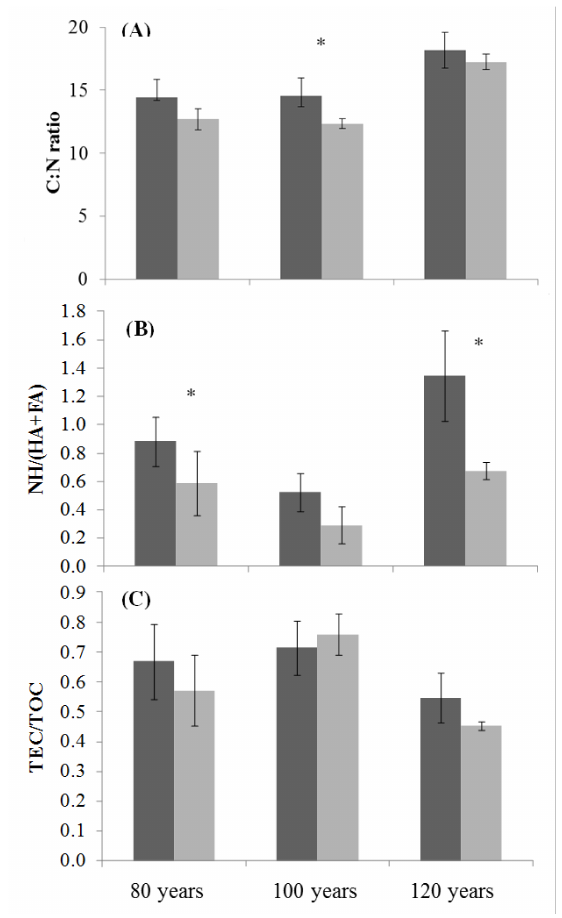
Figure 5. Soil organic matter properties in the epipedon (dark grey) and endopedon (light grey) along the Douglas fir stand chronosequence: C:N ratio ( A ), humification index: non-humic (NH) to humic carbon ratio ( B ), extractable to total carbon ratio ( C ). Bars are standard errors, asterisk indicate significant difference (* p ≤ 0.05) between epipedon and endopedon at each stand age ( n =